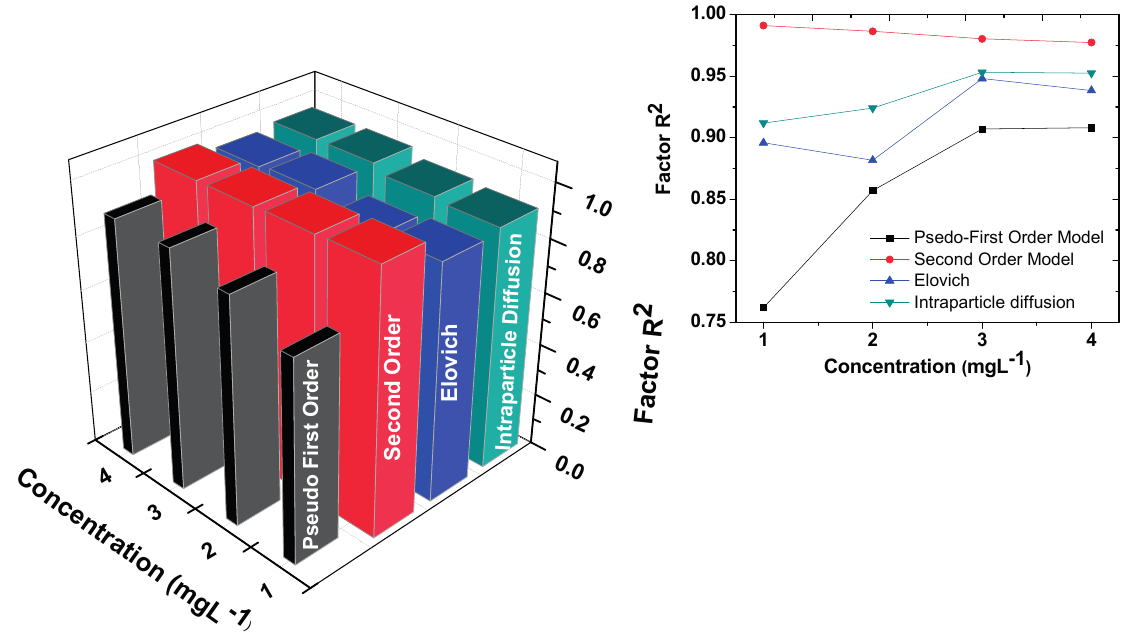
Figure 6. Analysis of the R 2 correlation values obtained from the theoretical models employed to describe the AgNPs adsorption process on zeolite.